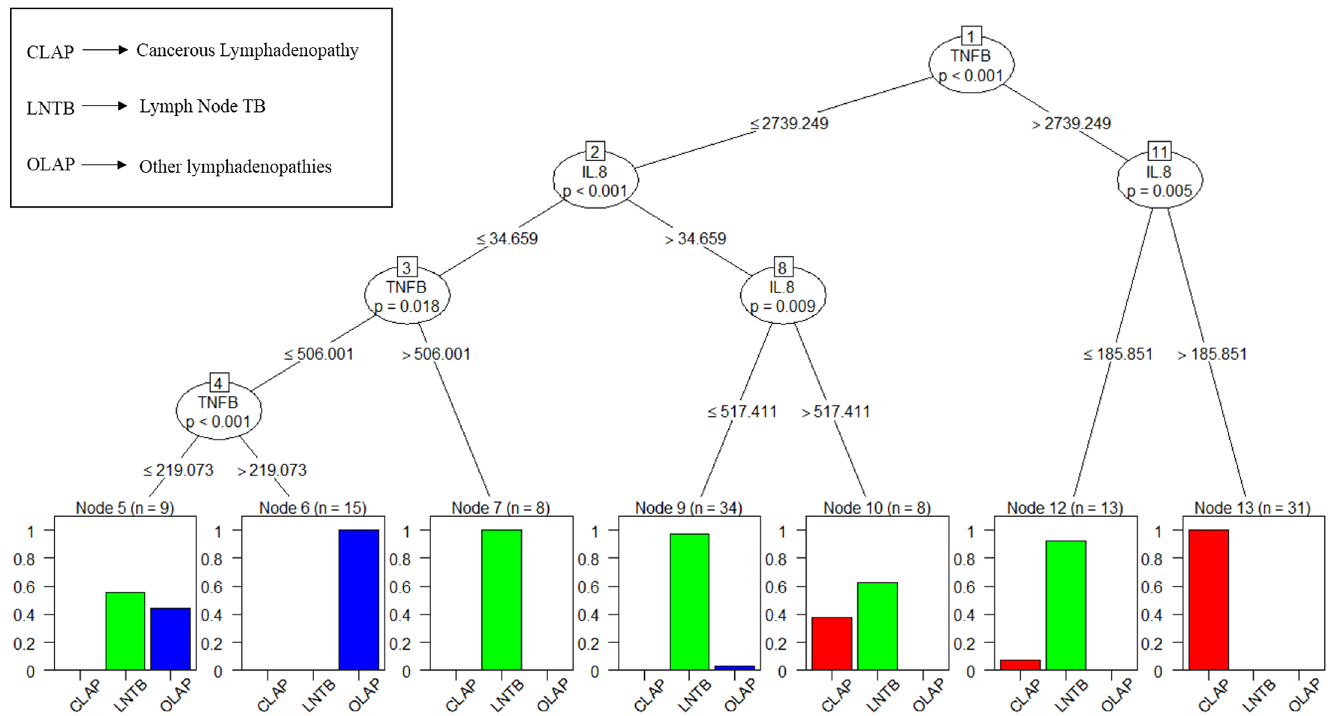
Fig 5. Conditional inference tree as applied to cytokine concentrations from all lymphadenopathies. For each inner node, the Bonferroni adjusted P- values are given. Concentrations are in ng/ml. For example in the terminal node 5, nine samples fulfilled the sequential criteria: (TNF- β < 2739.25) and (IL- 8 < 34.659) and (TNF- β < 506) and (TNF β < 219.07). The bars represent probabilities of belonging to respective classes, in this case 60% probability of patient being cancerous, 40% probability of the patient being Other LAP, and 0% chance of being LNTB. Decision tree was made on full data and since the multinomial logistic model was validated on a held-out